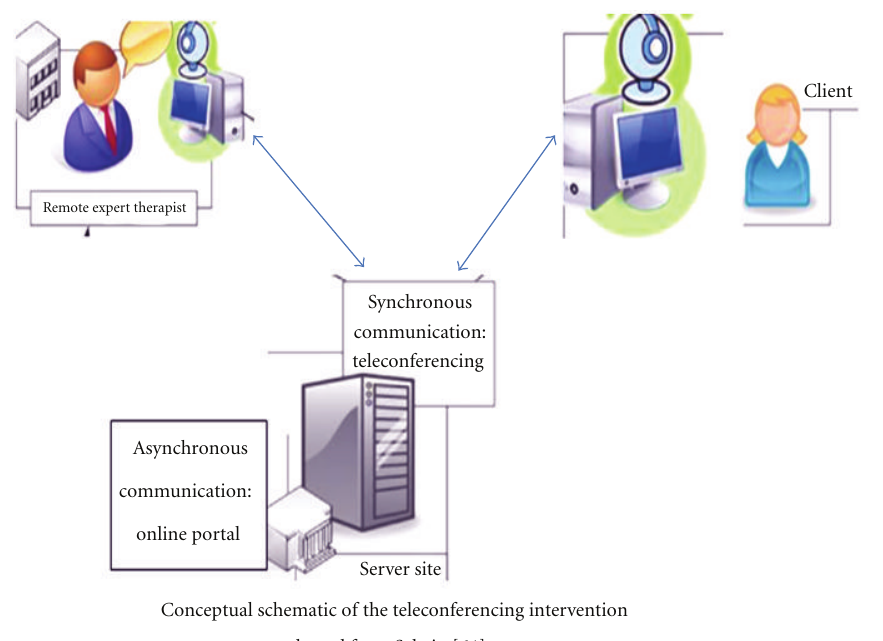
Figure 1: Conceptual schematic of teleconferencing intervention adapted with permission from Schein [64].